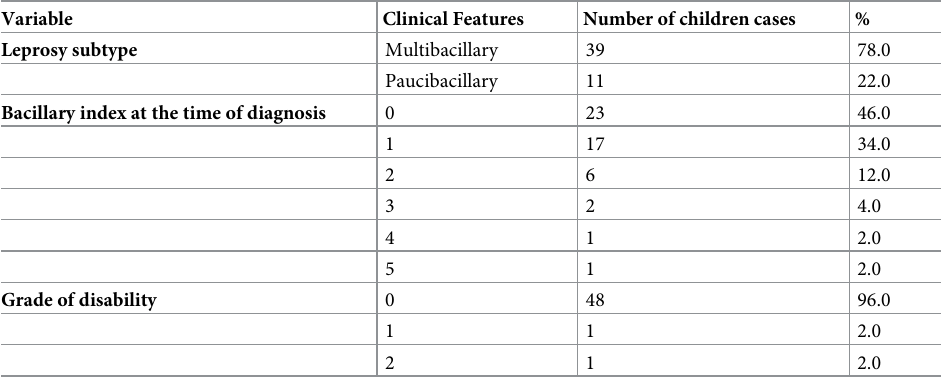
Table 4. Clinical features of childhood leprosy in Cuba (n = 50).